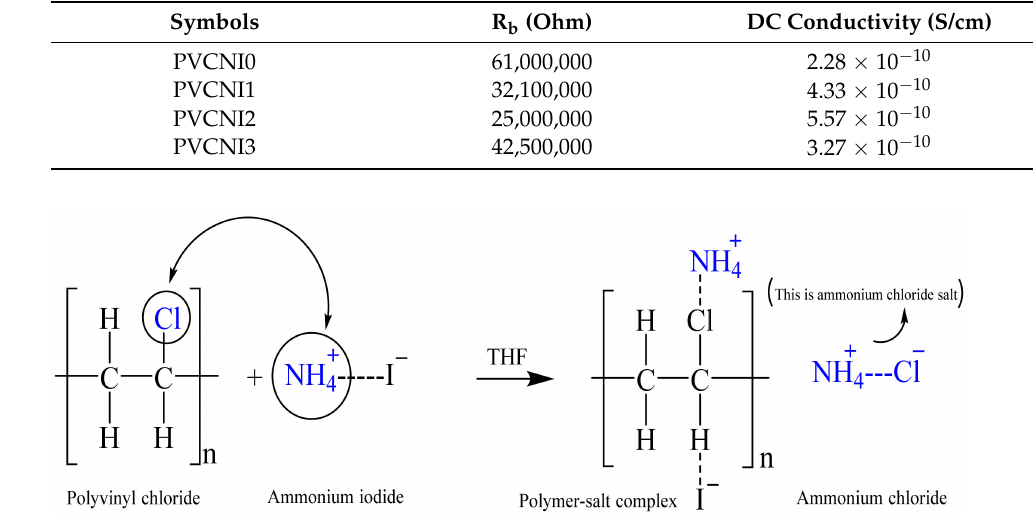
Figure 3. Schematic illustration of interaction between PVC host polymer and NH 4 I salt. The tight binding of NH 4 cation with Cl-side chain of PVC backbone is responsible for low conductivity of PVC-based